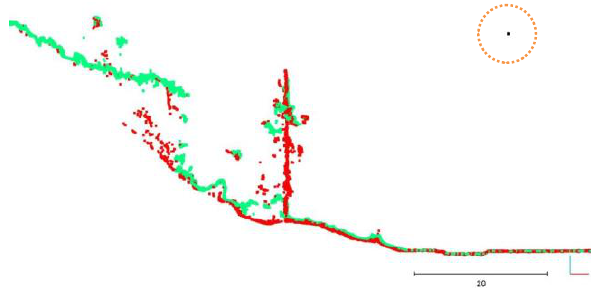
Figure 7. Cross section of the forested area. Green indicates the point cloud of the laser scanner, and red indicates the point cloud of photographic 3D reconstruction.